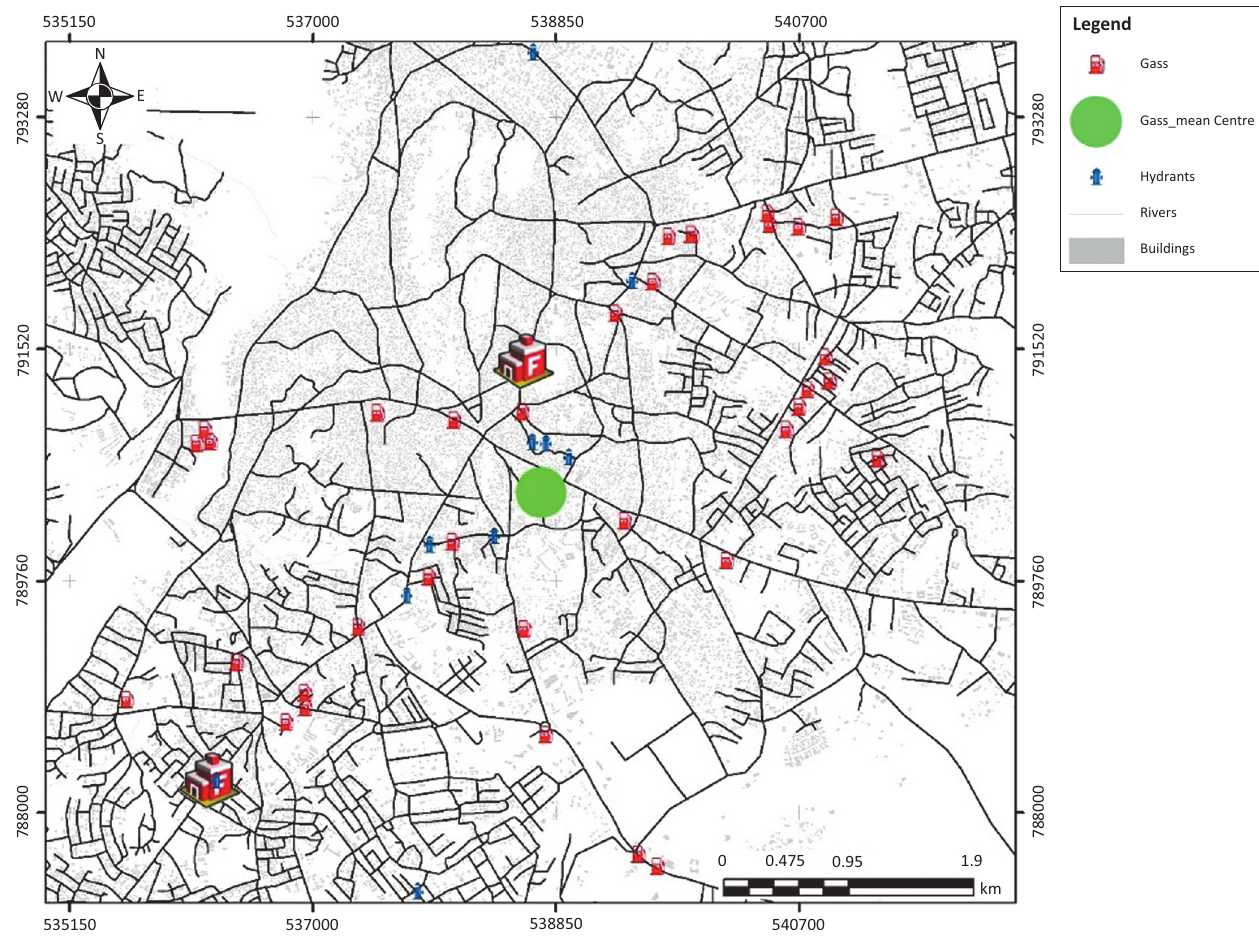
FIGURE 8: Spatial distribution of gas stations.